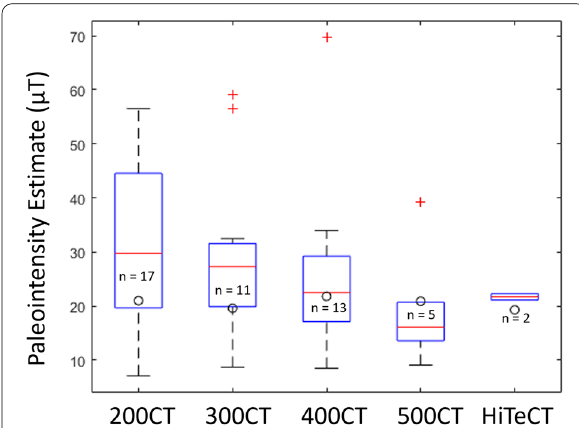
Fig. 5 Boxplot showing mean paleointensity estimate versus experiment type. The blue box shows the boundaries of the first (25%) and third (75%) quartiles. The black dashed lines represent the minima and maxima (excluding outliers). Red crosses represent substantial outliers in the data. The black circle is the expected paleointensity estimate, based on the data presented in Table 3. This plot was generated using MATLAB’s built-in boxplot script. This figure shows that the median paleointensity estimate decreased as the initial temperature increased from 200 °C to 500 °C. Table 4 shows that the mean PI estimate decreased as